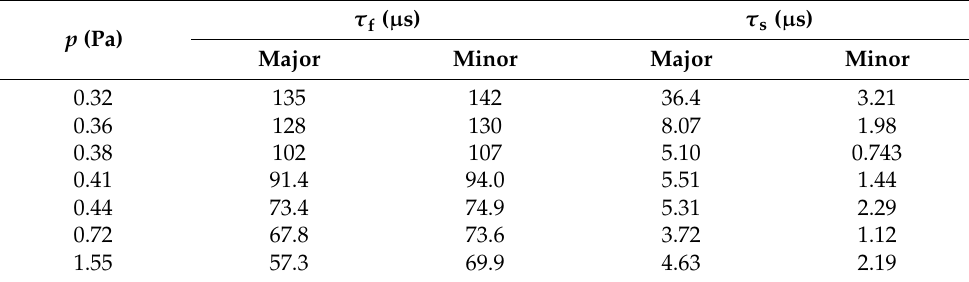
Table 2. Summary of delay times observed in the present